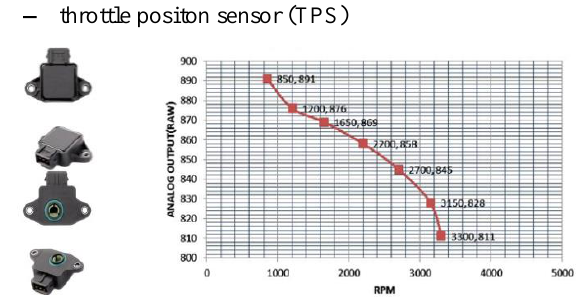
Fig. 8. Throttle Position Sensors with analog output vs. rpm